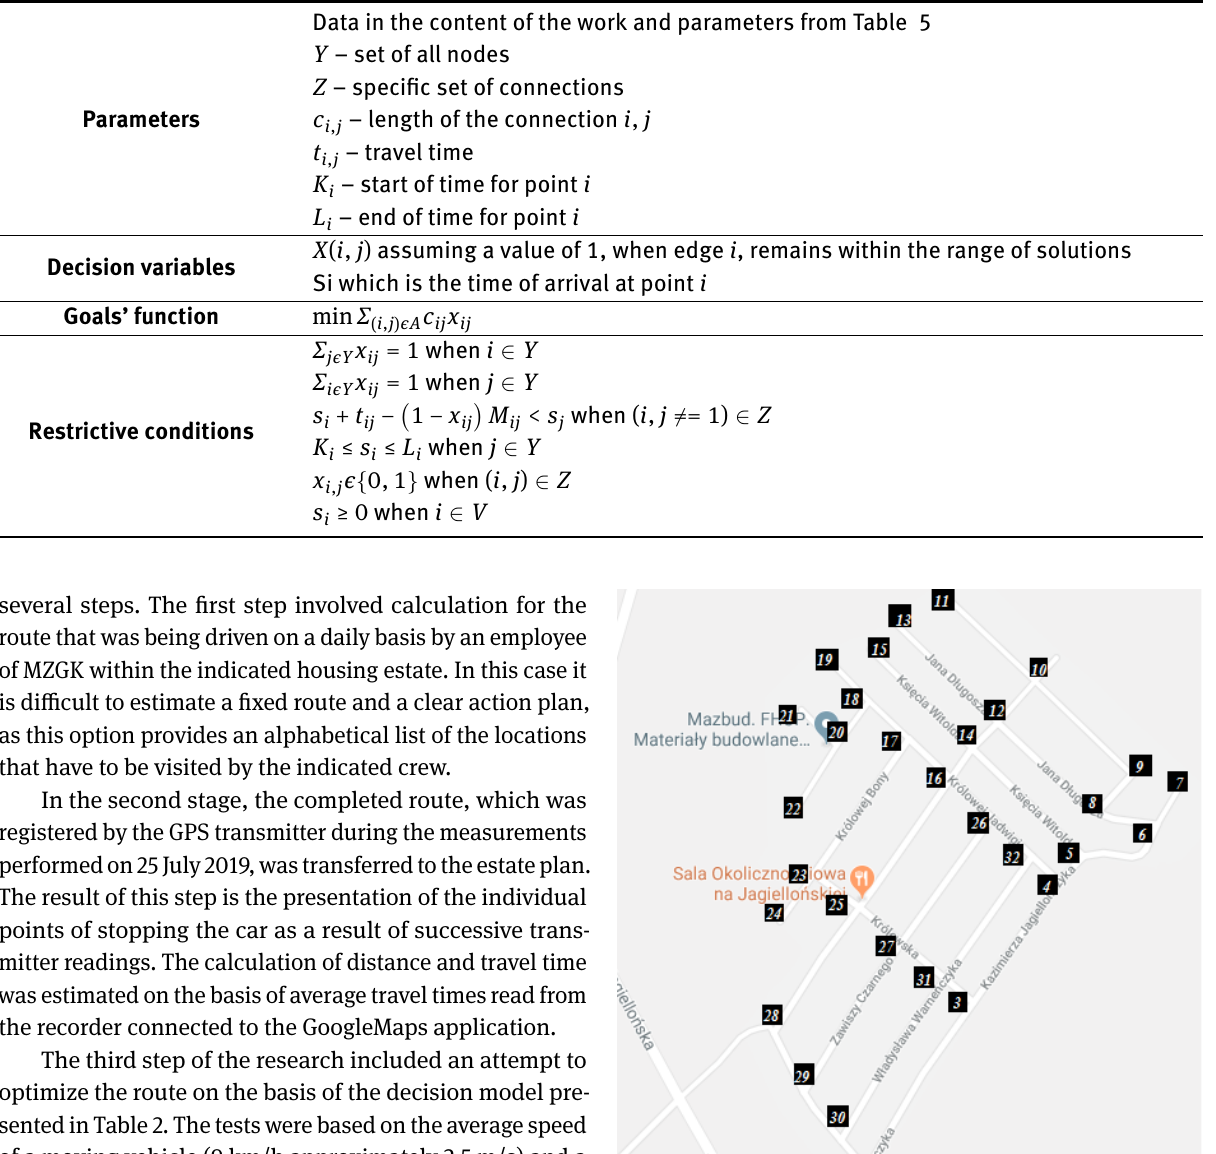
Table 2: Routing optimization model for the urban cleaning vehicle in Dęblin